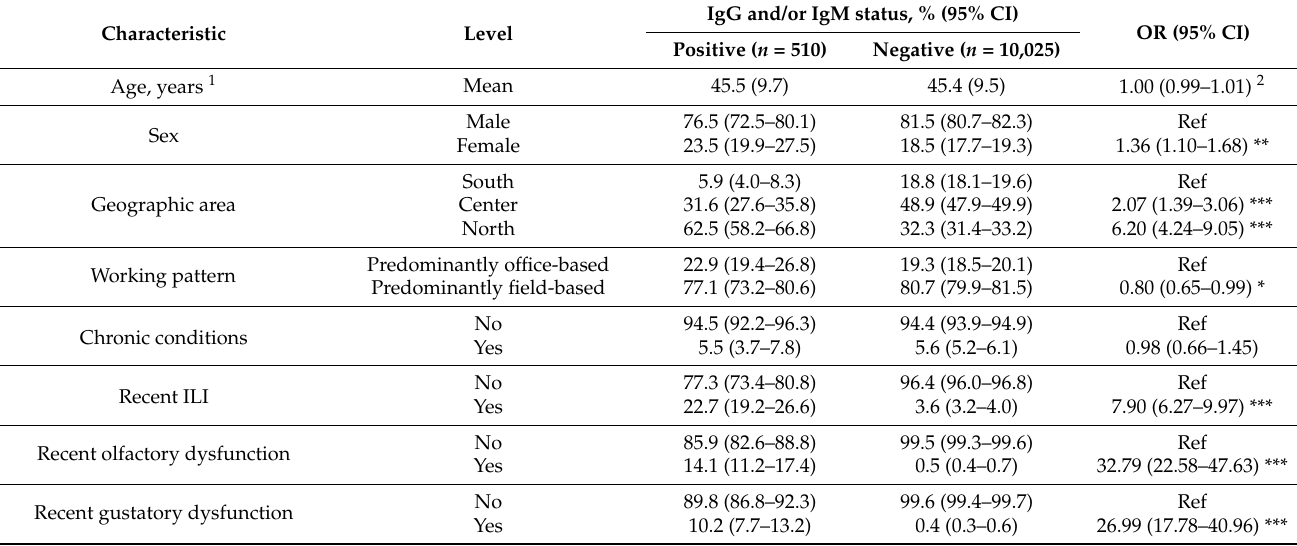
Table 2. Comparison between seropositive and seronegative subjects.